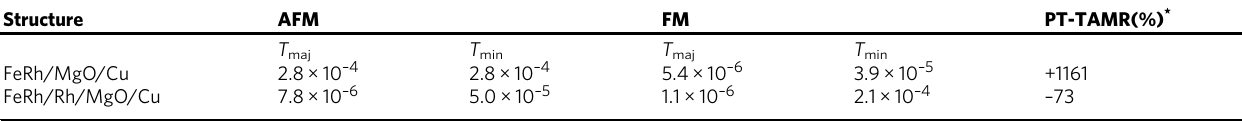
Table 1 Transmission and PT-TAMR ratio of α ′ -FeRh/MgO/Cu and α ′ -FeRh/Rh/MgO/Cu junctions Structure